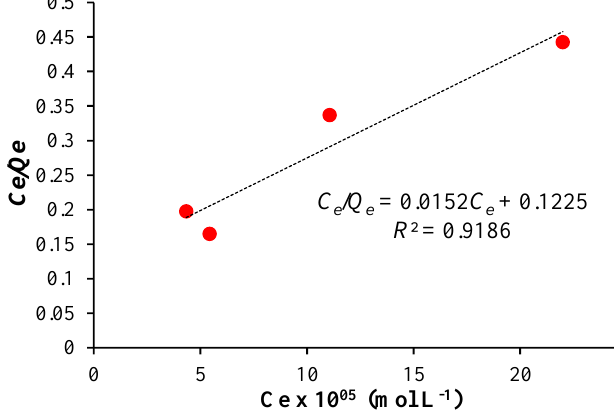
Figure 7. Langmuir isotherm graph for ARS adsorption on [PP@AA-TiO 2 ] A .